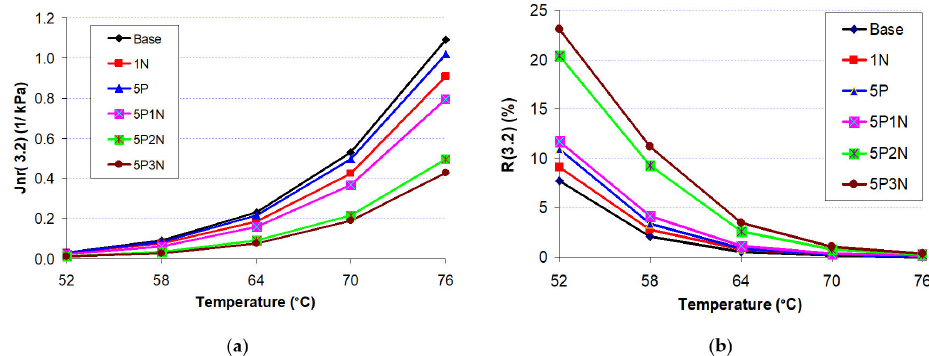
Figure 7. MSCR parameters at different temperature: ( a ) average non-recoverable creep compliance (J nr ) at 3.2 kPa; ( b ) average percent recovery (R) at 3.2